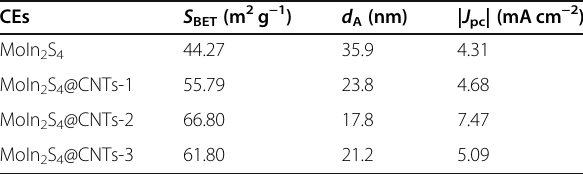
Table 1 The parameters of N 2 absorption-desorption isotherms of various samples